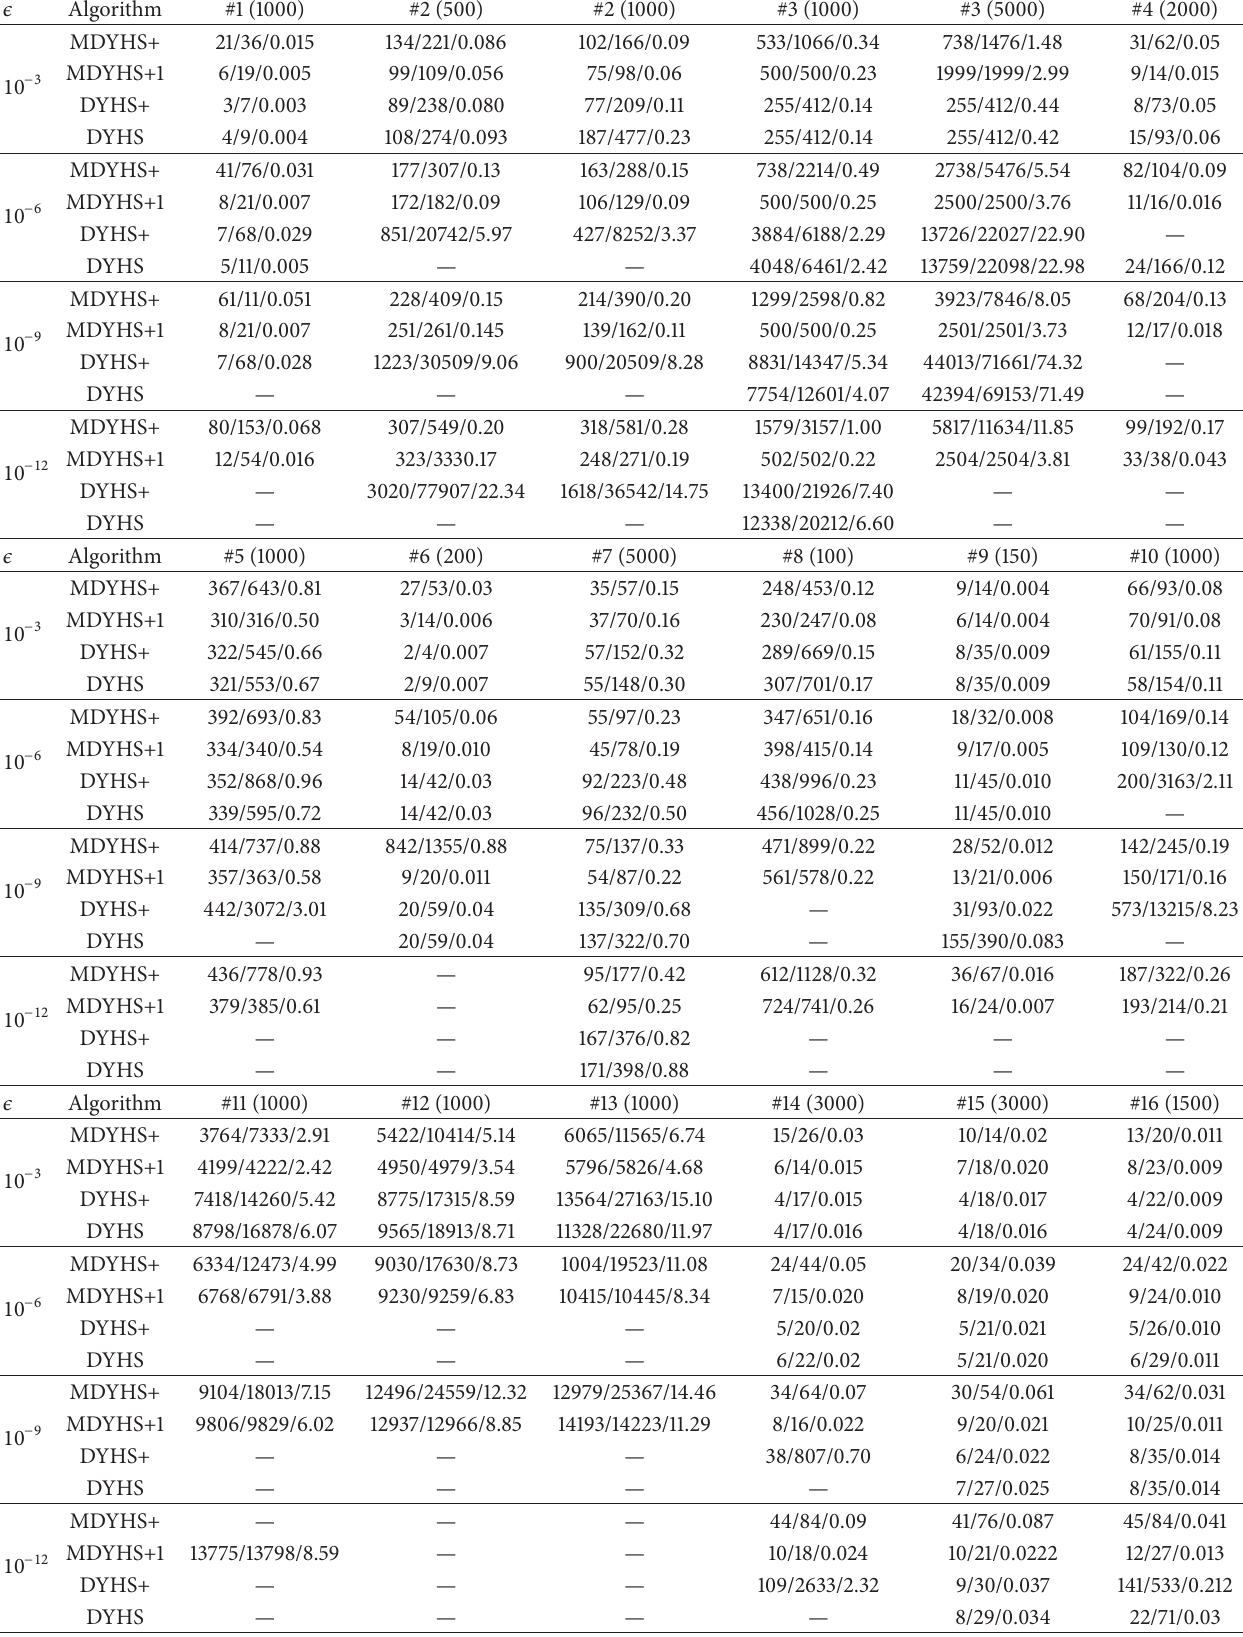
Table 2: Numerical results for test problems from the CUTEr